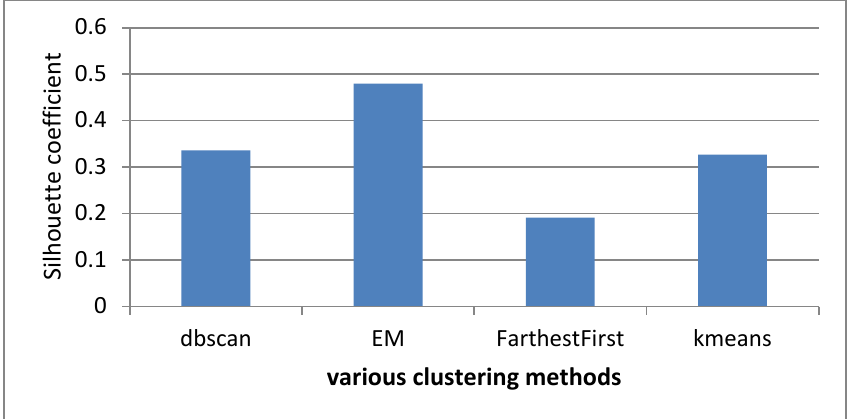
Figure 14. Silhouette coefficient on the idle mode scenario with the number of 3 clusters.